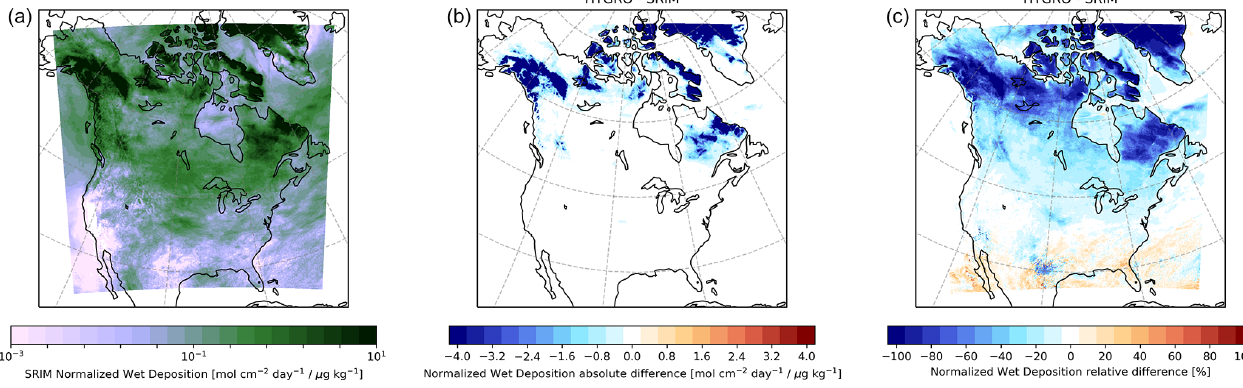
Figure 2. (a) Temporal means of wet deposition fluxes normalized by surface total aerosol concentrations from the SRIM simulation, (b) mean difference in normalized wet deposition fluxes between the HYGRO and SRIM simulations, and (c) relative difference in mean normalized wet deposition fluxes between the HYGRO and SRIM